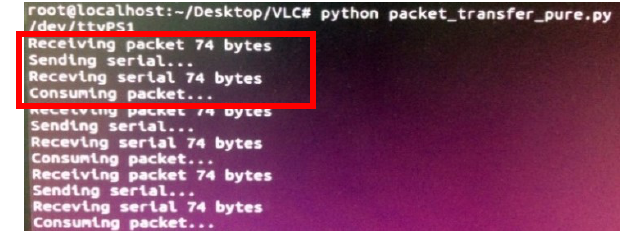
Figure 14. A photograph of the PC monitor connected